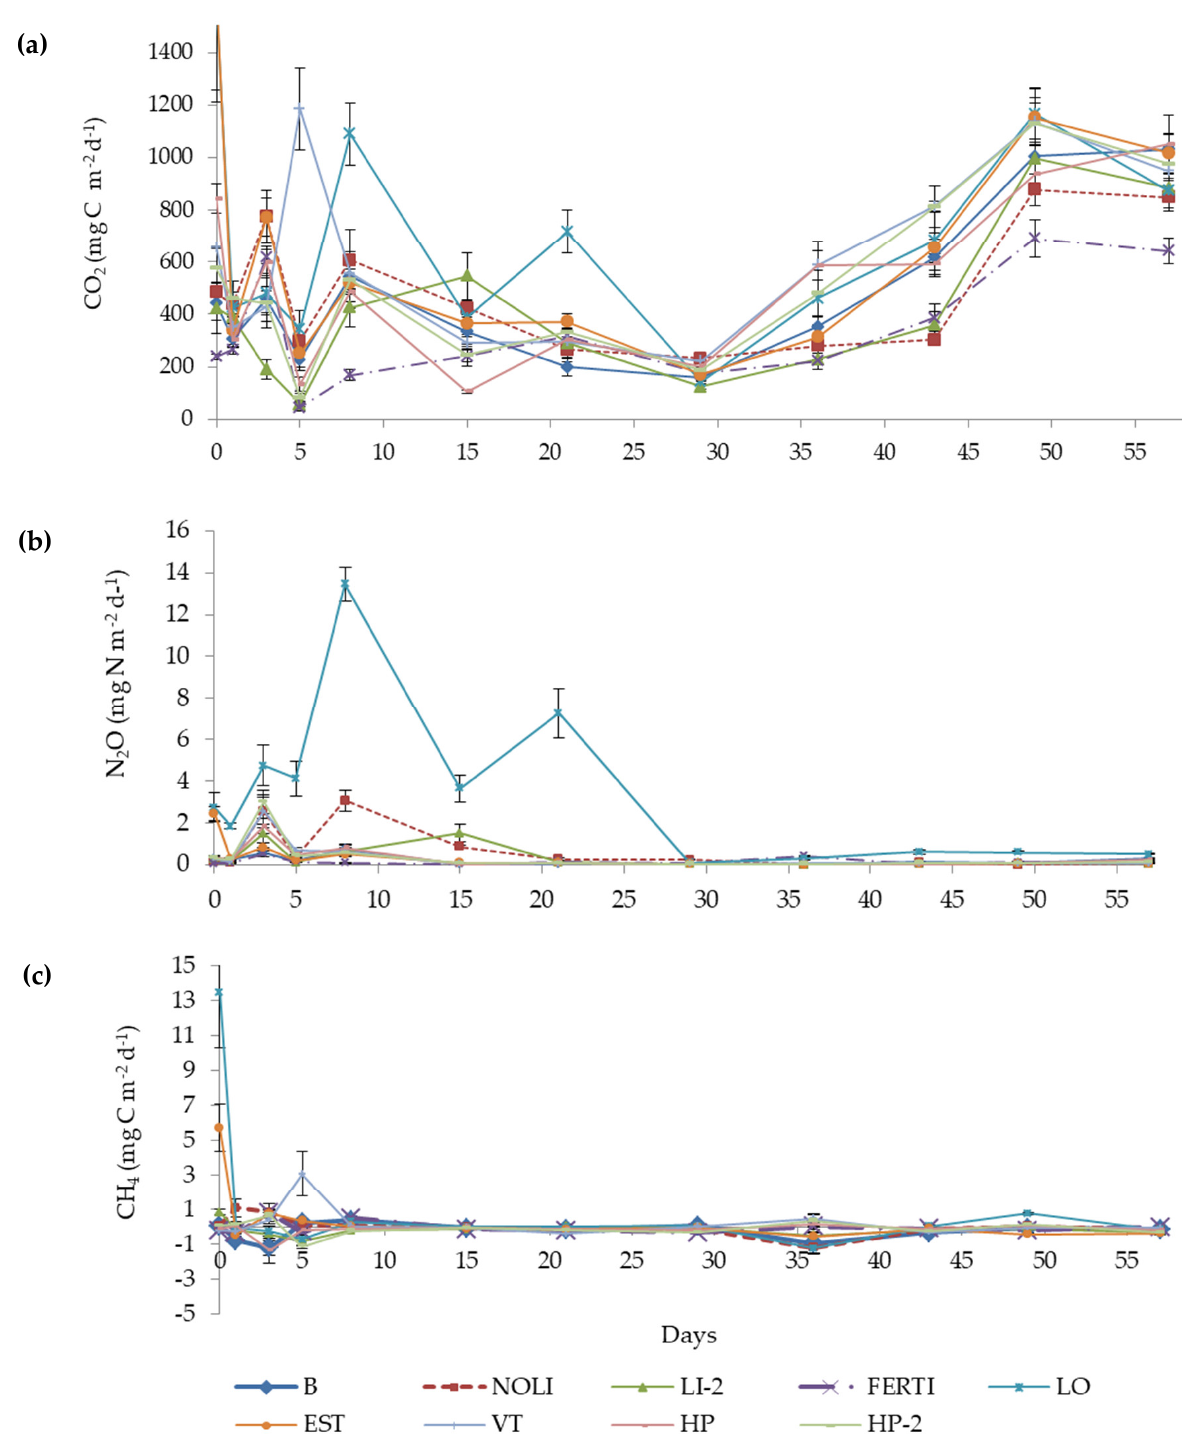
Figure 3. Daily fluxes of ( a ) CO 2 , ( b ) N 2 O, and ( c ) CH 4 from treatment applications during the 55-day monitoring period. HP: wastewater treatment biosolid + Phoenix dactilifera leaf prunings; HP-2: agrifood sludge from pear processing wastewater + Phoenix dactilifera leaf prunings; VT: vermicompost cow manure; LO: biosolid; EST: cow manure; NOLI: NPK inorganic fertilizer; LI-2: NPK + DMPP inorganic fertilizer; FERTI: fertigation. Bars represent the standard error of the mean.